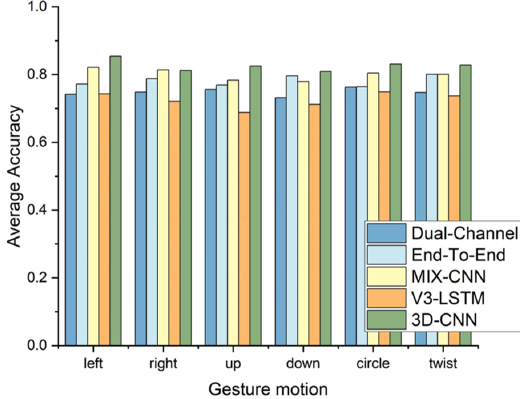
Figure 21. Comparison of the recognition effect.